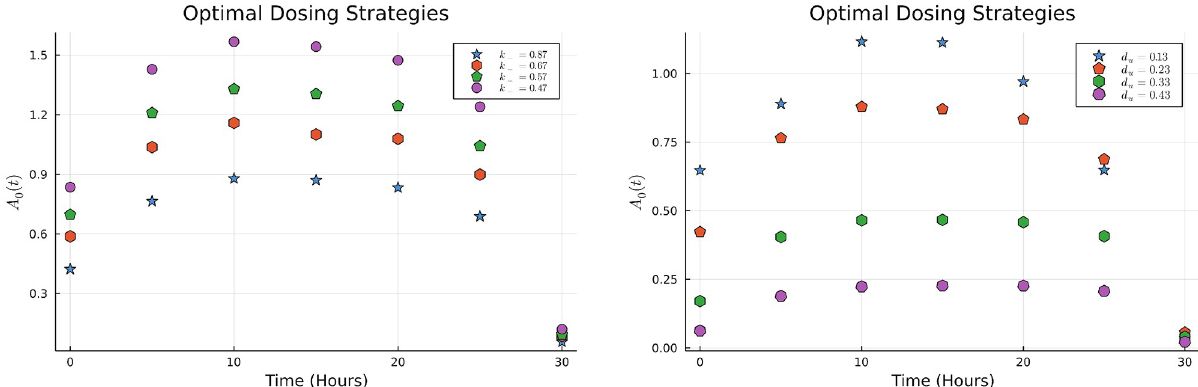
Fig 8. The left figure shows the optimal dosing strategies for various k + . The right figure shows the dosing strategies for various values of washout parameter d u